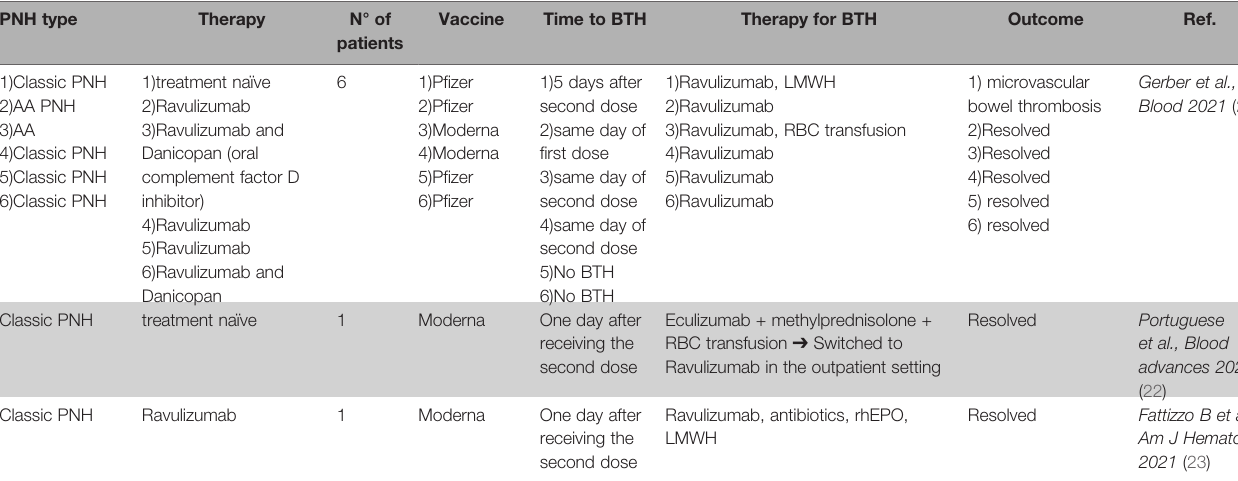
TABLE 2 | Hemolytic fl ares in patients with paroxysmal nocturnal hemoglobinuria after SARS-CoV-2